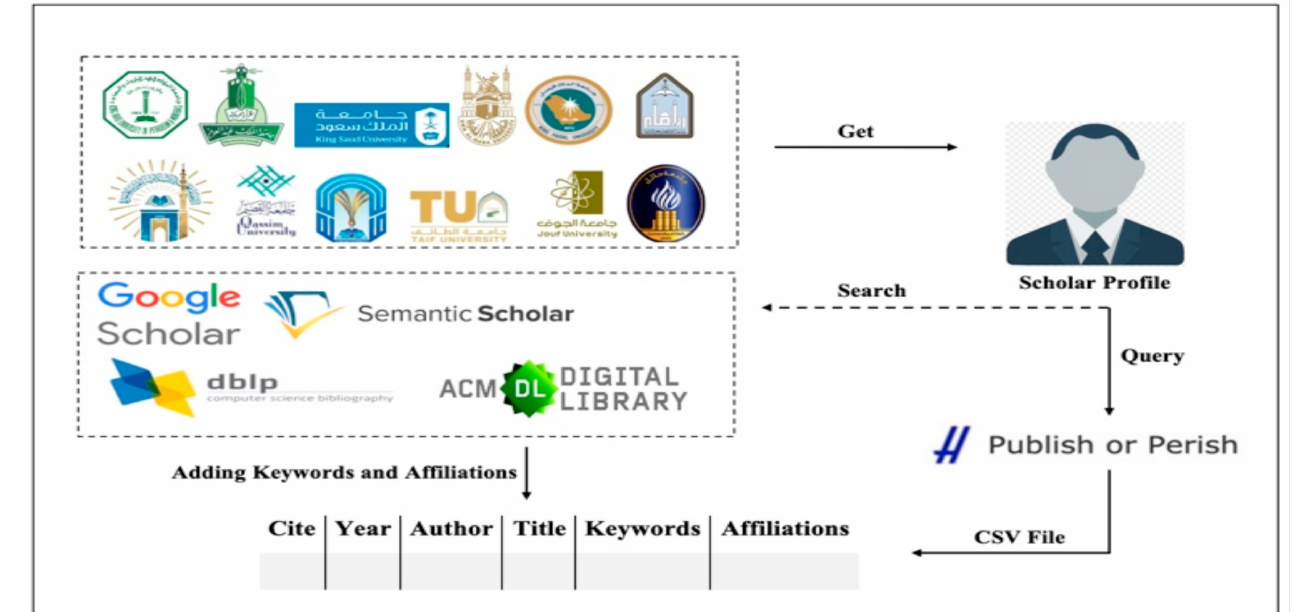
Figure 4. Process of collecting the academic